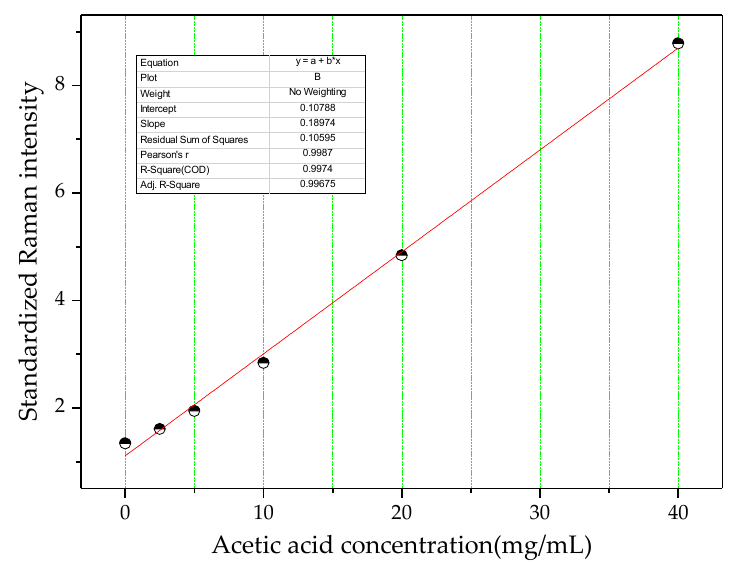
Figure 8. Raman spectra of oil-dissolved acetic acid samples at different concentrations.